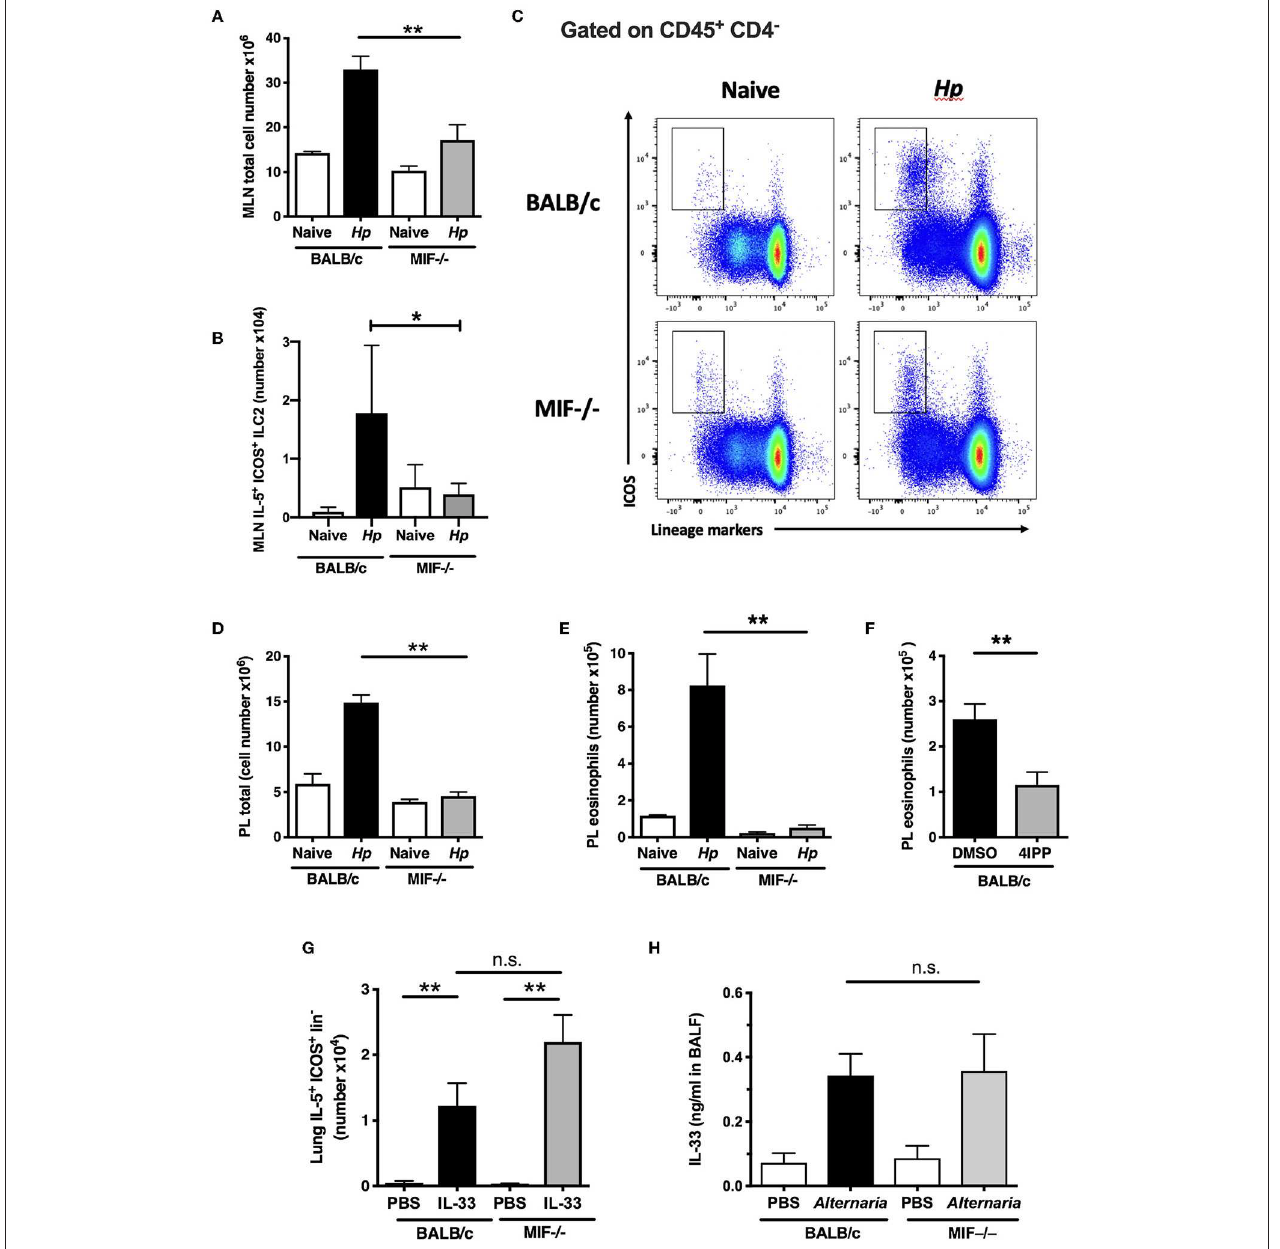
FIGURE 3 | Impaired innate type 2 responses in MIF-deficient mice. (A) Total numbers of MLN cells recovered from BALB/c and MIF − / − mice 7 days following H. polygyrus infection. Data are representative of two independent experiments. (B) Differential induction of ILC2s in BALB/c and MIF − / − mice following H. polygyrus infection. Total numbers of IL-5 + ICOS + lineage − ILC2s within MLNC from naïve and d7 H. polygyrus -infected BALB/c and MIF − / − mice. Data are representative of two independent experiments. (C) Representative flow cytometry plots of ICOS vs. Lineage markers in MLN cells from BALB/c and MIF − / − naive mice and 7 days following H. polygyrus infection. (D) Total numbers of peritoneal lavage cells recovered from BALB/c and MIF − / − mice 7 days following H. polygyrus infection. Data are representative of two independent experiments. (E) Differential induction of eosinophilia in BALB/c and MIF − / − mice following H. polygyrus infection. Total numbers of eosinophils (SiglecF + CD11b + ) in naïve and H. polygyrus- infected BALB/c or MIF − / − mice within the peritoneal lavage, at day 7 post-infection. Data are representative of two independent experiments. (F) The MIF inhibitor 4-IPP inhibits eosinophilia in BALB/c mice infected with H. polygyrus. Eosinophil numbers at day 7 post-infection with H. polygyrus in BALB/c following administration of 1mg of the MIF inhibitor, 4-IPP, assessed as SiglecF + CD11b + cells within the peritoneal lavage. Results are combined from two experiments with similar results. (G) MIF − / − mice do not have an intrinsic defect in ILC2 induction. IL-5 + ILC2s as a proportion of live cells in digested lung tissue of BALB/c or MIF − / − mice treated intranasally with PBS or rIL-33, measured by flow cytometry. Data are representative of two independent experiments, and were analyzed by nonparametric statistics. (H) MIF − / − mice have normal ability to release the key alarmin IL-33 upon stimulation. Levels of IL-33 in BALF of BALB/c or MIF − / − mice 1h after intranasal administration of 10 µ g Alternaria antigen, measured by ELISA. Results are combined from two experiments with similar results. n.s., not significant, * p < 0.05, ** p < 0.01.